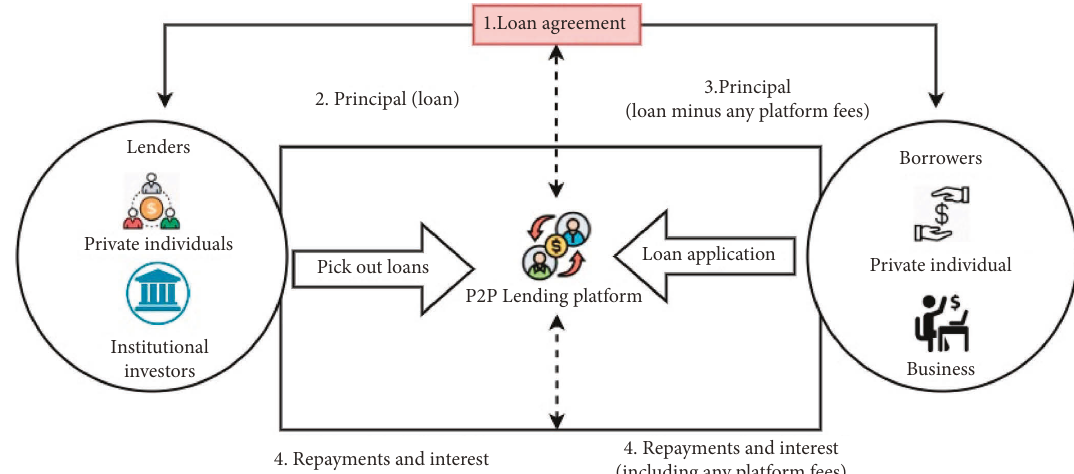
Figure 4: Credit risk modeling using machine learning